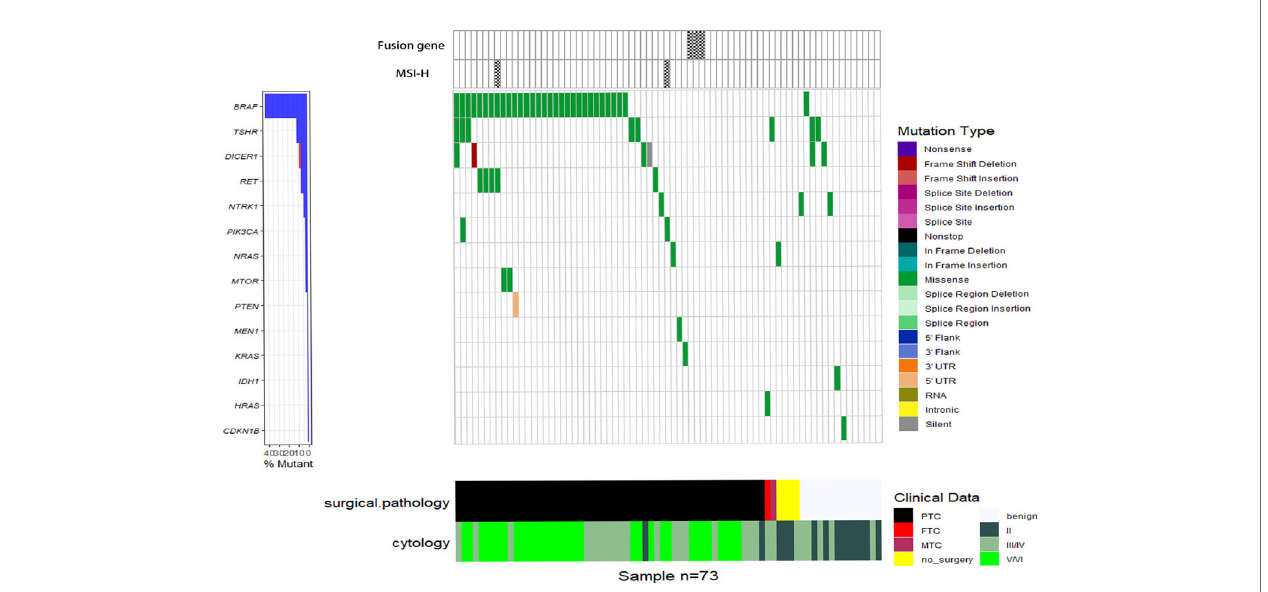
FIGURE 1 | Waterfall plot of SNVs, fusion genes, and MSI-H status detected by NGS. Various types of SNVs, fusion genes and MSI-H status of 73 FNA samples (each vertical column represents a sample) tested by the ThyroLead panel are displayed and the corresponding cytology/pathology of each sample was listed in the bottom. Mutations of different types are marked with respective colors and the spoted grids on the top mean positive fusion genes or MSI-H